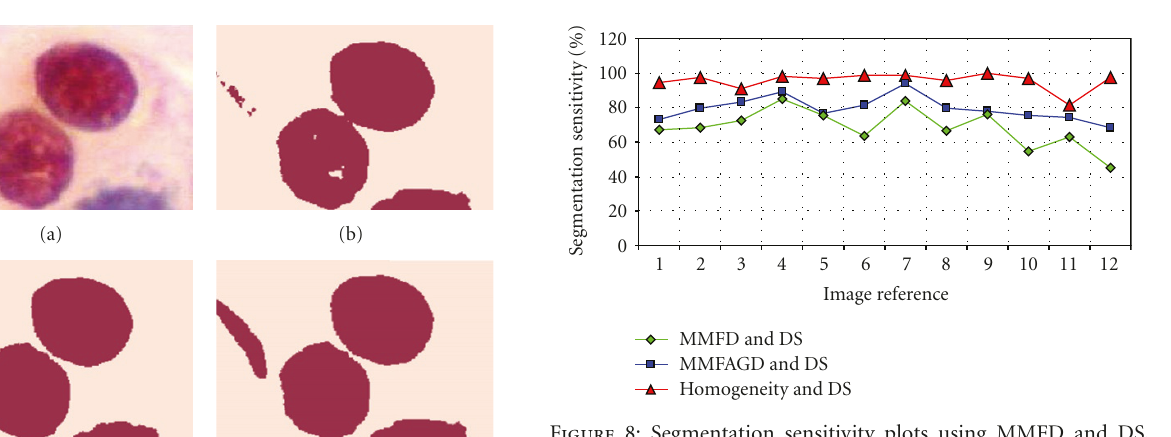
Figure 8: Segmentation sensitivity plots using MMFD and DS, MMFAGD and DS and homogeneity method and DS for the data set shown in Figure 5.